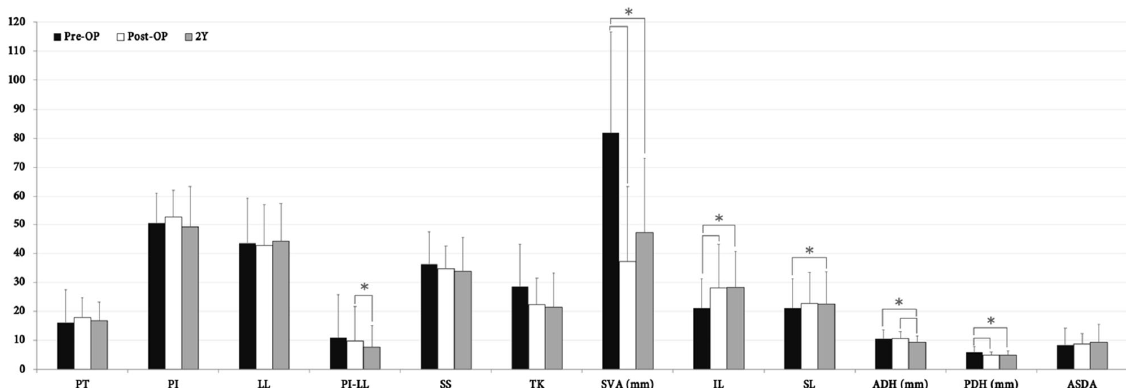
Figure 5. Radiographic outcome measured at pre-OP, post-OP, and 2-year follow-up amongst OLIF group ( n = 25). *, statistically significant between measurements ( p < 0.05). PT, pelvic tilt; PI, pelvic incidence; LL, lumbar lordosis; PI-LL, PI minus LL; SS, sacral slope; TK, thoracic kyphosis; SVA, sagittal vertical axis; IL, index lordosis; SL, segmental lordosis; ADH, anterior disc height; PDH, posterior disc height; ASDA, adjacent segment disc angle; Y, year. After matching for gender and age, patients receiving ALIF and OLIF were compared for radiographic (Table 2) and functional outcomes (Table 3). All baseline radiographic parameters demonstrated no significant differences. IL, SL and PDH were smaller at post-OP and 2-year follow-up, whilst ADH was smaller only at 2-year follow-up in the OLIF group. ASDA and sagittal parameters, including PT, PI, LL, PI-LL, SS, TK, and SVA, demonstrated no significant differences between the two groups (Table 2). Table 2. Comparison of radiographic outcome of the study population stratified by lumbar interbody fusion types. ALIF OLIF Overall p -Value PT ( ◦ ) Pre-OP 13.9 ± 12.1